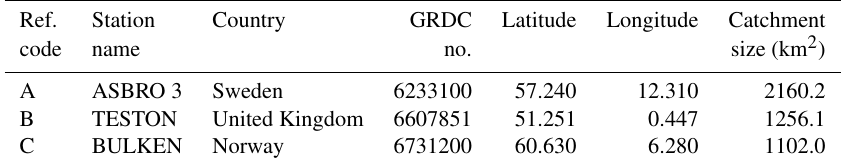
Table 5. General information about selected sites shown in Fig. 7. Ref. code is the number of the subplot of Fig. 7. Ref.